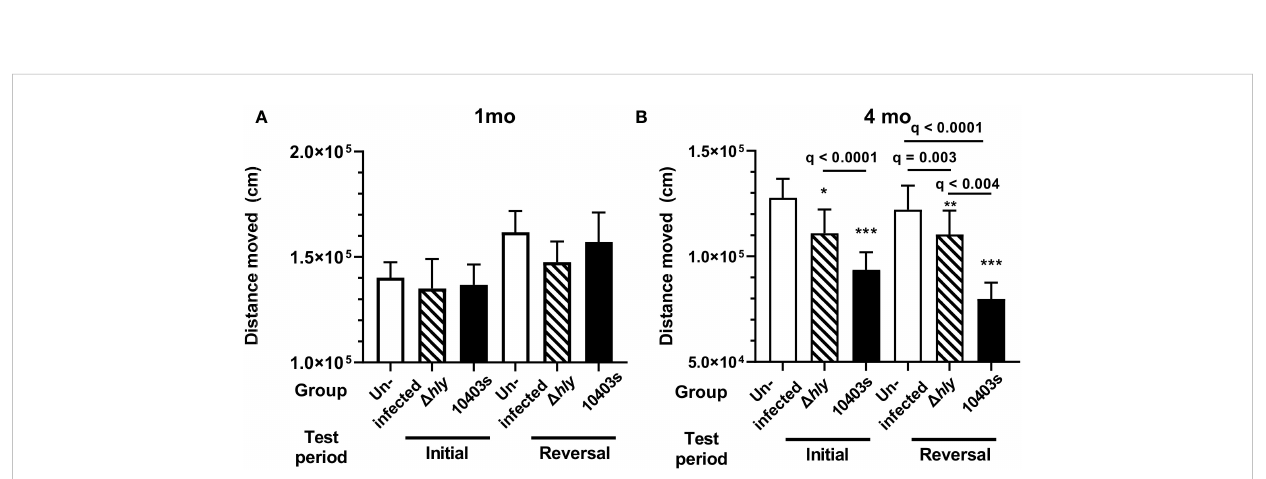
FIGURE 5 Lm infection reduces spontaneous distance moved. Movement over 89h was measured in uninfected mice (open bars), mice infected with Lm D hly mutants (hatched bars) and Lm 10403s (solid bars) during initial and reversal phases at 1 mo p.i. (A) and 4 mo p.i. (B) . Columns in panels represent mean + SEM distance moved in initial and reversal phases. 2-way ANOVA was used to identify discoveries (q < 0.05) between D hly Lm and Lm 10403s compared with uninfected mice in the same period are shown as *q < 0.05, **q < 0.01, ***q < 0.001. Discovery q values between other groups are